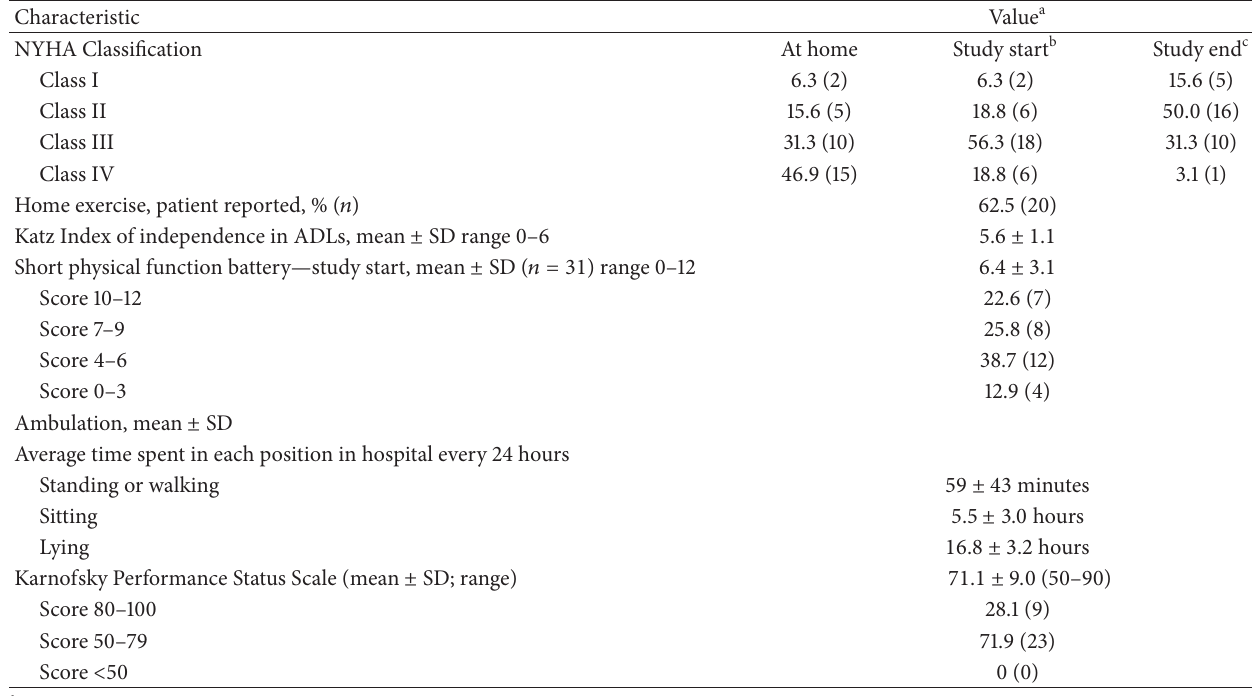
Table 4: Functional status of study patients.